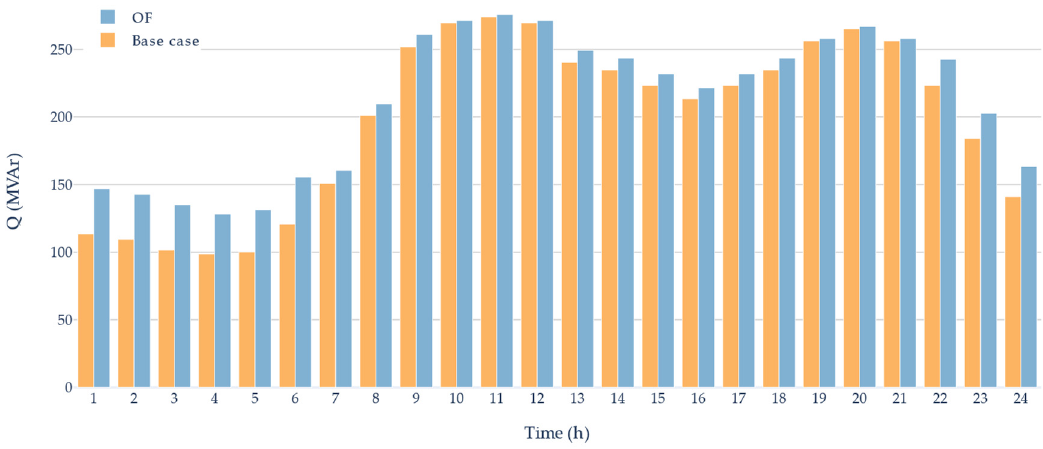
Figure 5. Absolute reactive power output of generators for each period for the IEEE 57-bus system .